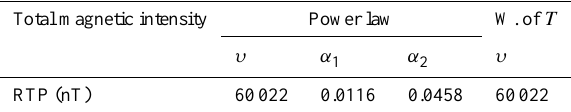
Table 2. Results obtained by using the power-law method and weights of evidence procedure; α 1 and α 2 are the exponents of the power-law relation for concentration values less and greater than the threshold value ( υ) ,